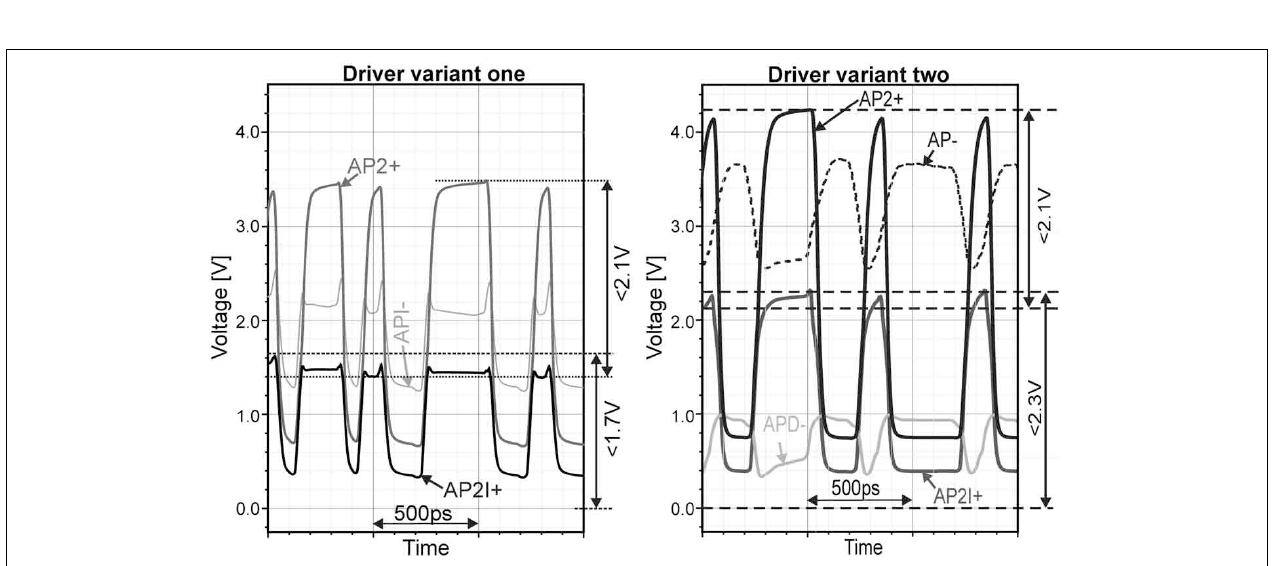
FIGURE 4 | Schematic of the output stages of the modulator drivers: The black drawn electrical components alone are the schematic of driver variant one. The black components including the light gray drawn components are the schematic of driver variant two.